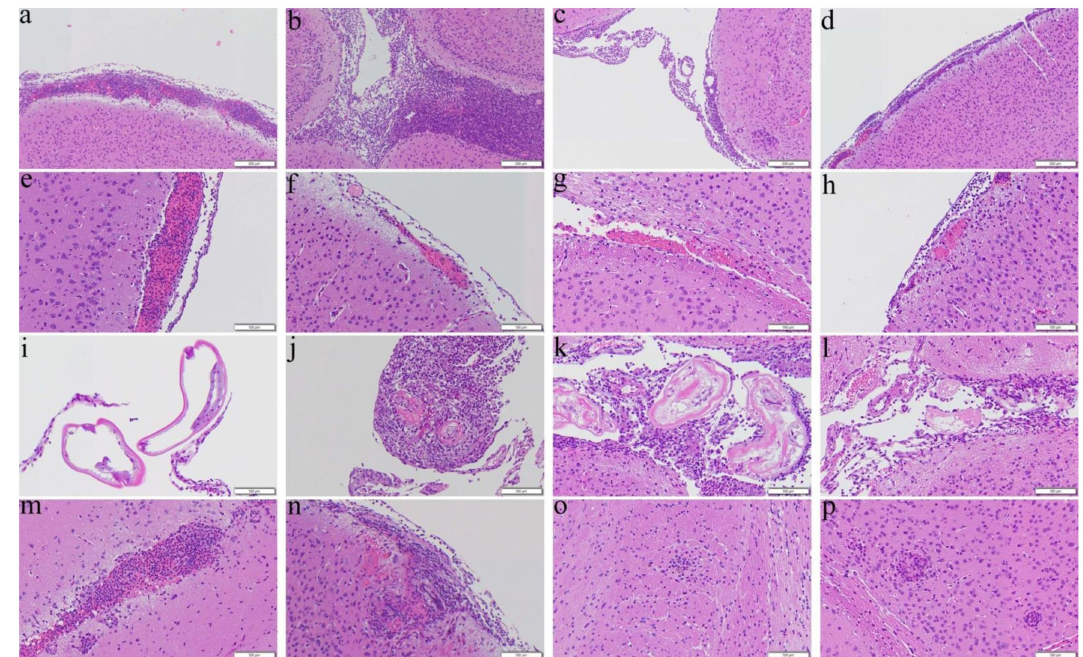
Figure 6. Representative photomicrographs showing meningitis, presence of worms, hemorrhage, and encephalitis in the cerebral parenchyma of the C57BL/6 mice infected with Angiostrongylus cantonensis treated from day 7 for 14 days. ( a , e , i , m ) Untreated mice. ( b , f , j , n ) Mice treated with albendazole alone. ( c , g , k , o ) Mice treated with dexamethasone alone. ( d , h , l , p ) Co-therapy of albendazole and dexamethasone.